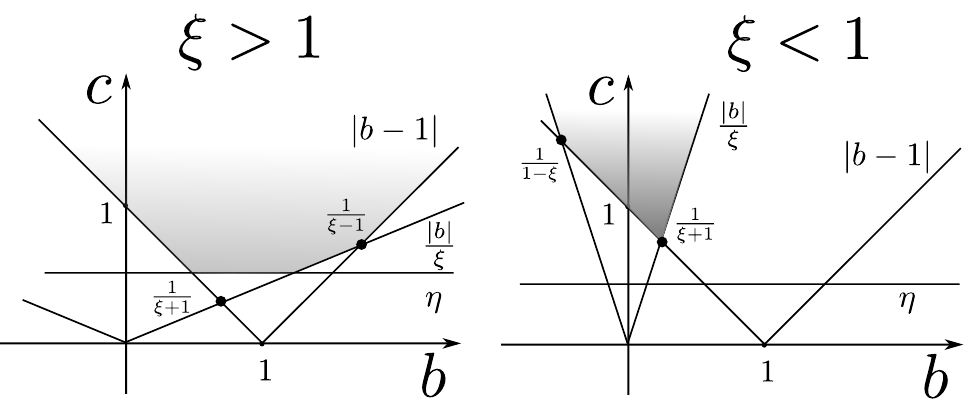
Figure 2 . The shaded area indicates the ranges for b and c allowed by the prior P 0 ( b, c ) , in eq. (3.17) and the inference from the universal input δ = 1 in eq. (3.15) for ξ > 1 (left) and ξ < 1 (right). 0 The position of c = η > 0 line is